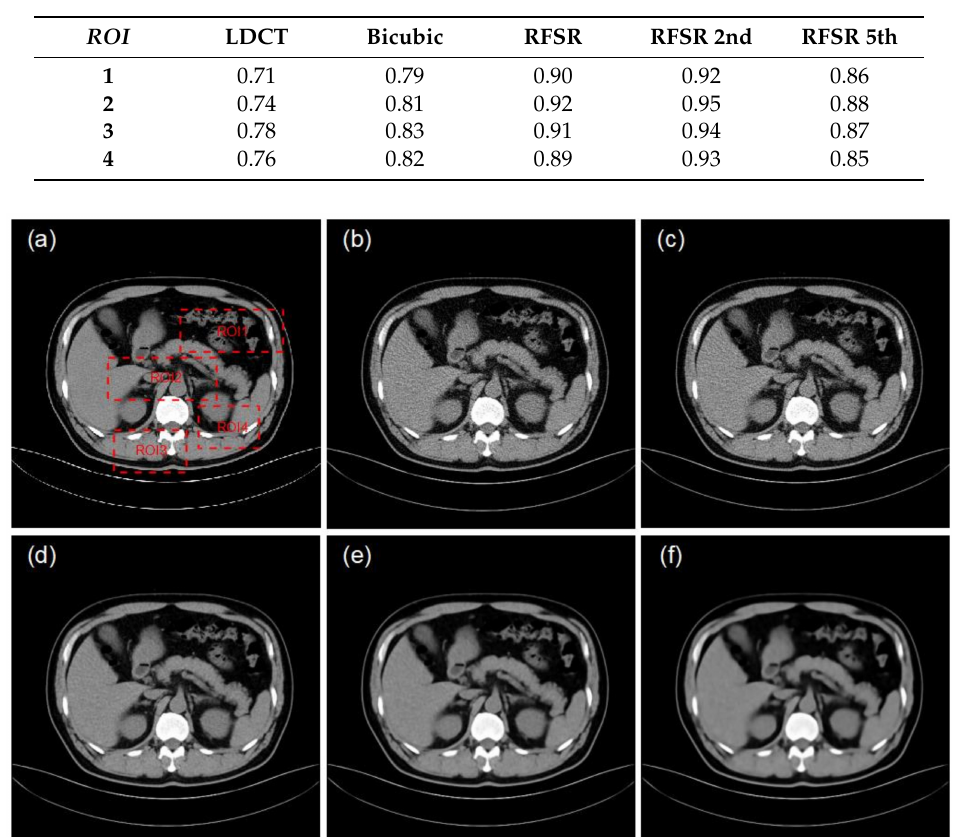
Figure 5. ( a ) HDCT image; ( b ) LDCT image; ( c ) Reconstructed image obtained using the bicubic interpolation method; ( d ) The image reconstructed by the method of this paper with 1 iteration; ( e ) The image reconstructed by the method of this paper with 2 iterations; ( f ) The image reconstructed by the method of this paper with 5